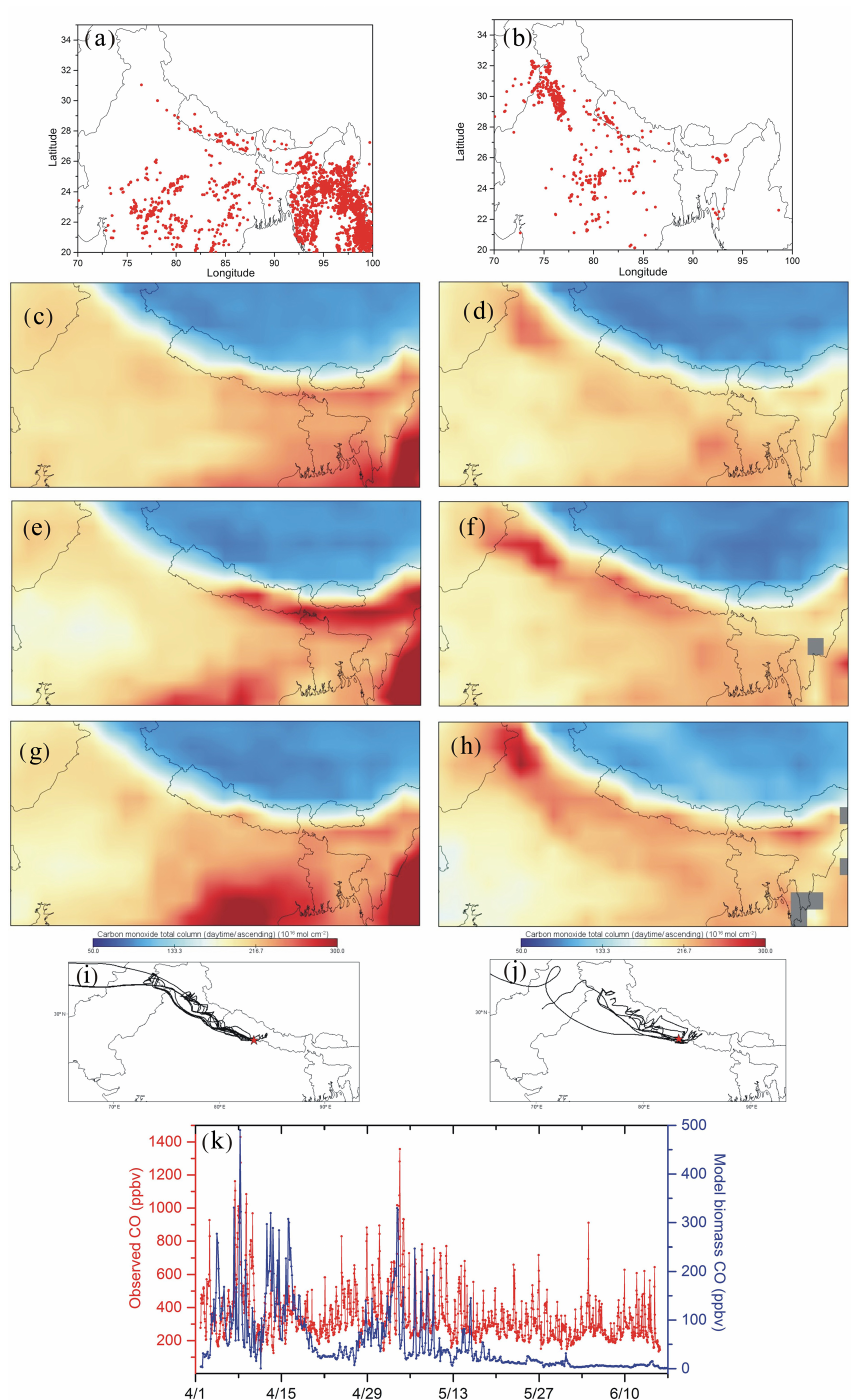
Figure 8. Active fire hotspots in the region acquired with the MODIS instrument on Aqua satellite during (a) Event I (7–9 April) and (b) Event II (3–4 May). CO emissions, acquired with AIRS satellite, in the region 2 days before (3–5 April), during (7–9 April) and 2 days after (10–12 April) the Event I are shown in panels (c, e, g) , respectively, while panels (d, f, h) show CO emissions 2 days before (1–2 May), during (3–4 May) and 2 days after (5–6 May) the Event II. Panels (i, j) represent the 6h interval HYSPLIT back trajectories during Event I and II, respectively. Location of the Lumbini site is indicated by the red star in the panels (i, j) . Observed CO vs. model open burning CO illustrating the contribution of forest fires during peak CO loading is shown in panel (k)